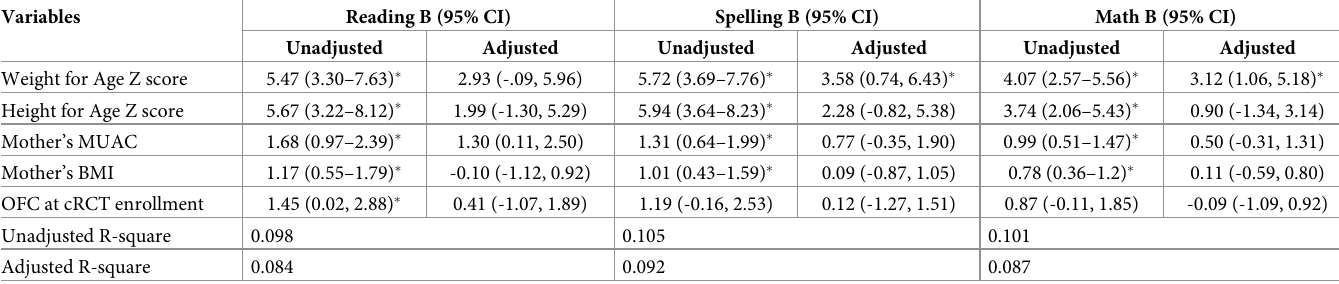
Table 3. Unadjusted and adjusted multiple linear regression analysis of the anthropometric indices on the school achievement score. Variables